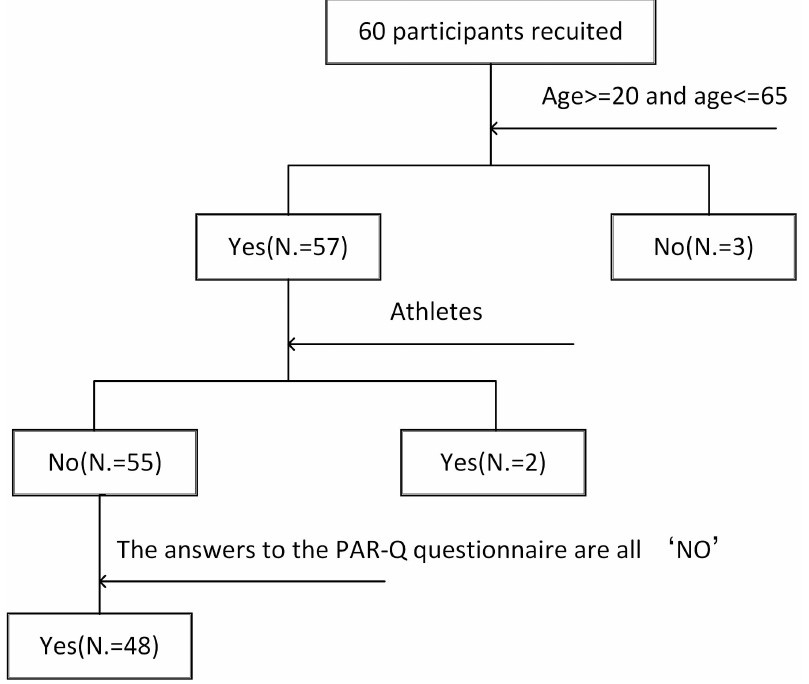
Figure 1. Flow diagram of the recruitment and screening of